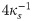
Spatial profiles around the gate’s edge.Shown are the densities of the approximate (dashed red) and actual, smeared out (solid red) charge distribution of the induced 2DEG. The latter one arises from the first one due to screening effects inside the semiconducting substrate, which smoothen the charge density in a narrow region of approximate thickness 4κs−1 around the gate’s edge with the screening length κs−1. The corresponding SAW speed c(x) (black) according to Eq 20 takes the values c0 and c0(1 + K2/2) with the piezoelectric coupling constant K2 in the region with high and low 2DEG density, respectively, and approximately aligns linearly in the transition region.